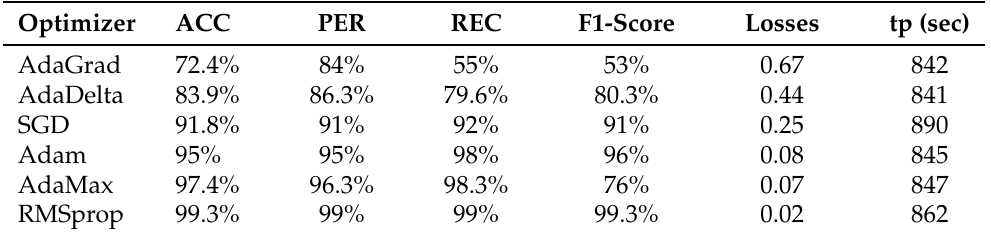
Table 2. Overall evaluation of the proposed model with different optimizers and the LeakyReLU activation function ( α = 0.1).